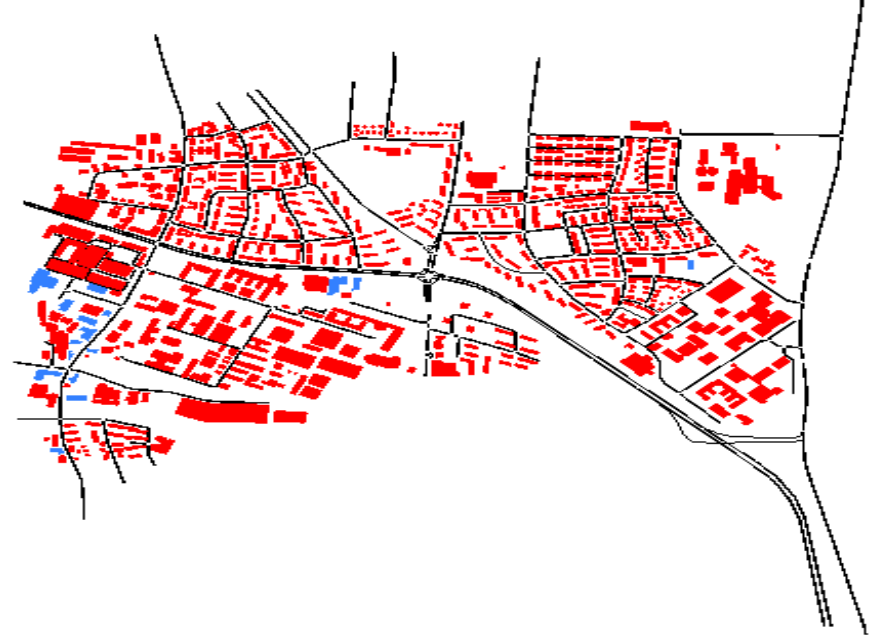
Figure 7. Imported map interface with SUMO for vehicles’